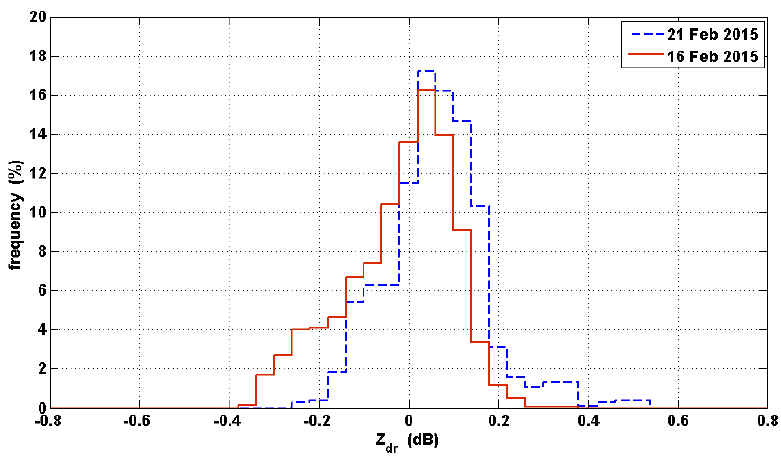
Figure 27. Differential reflectivity ( Z dr ) histograms for the 16 February 2015 graupel and 21 February 2015 snow band cases.